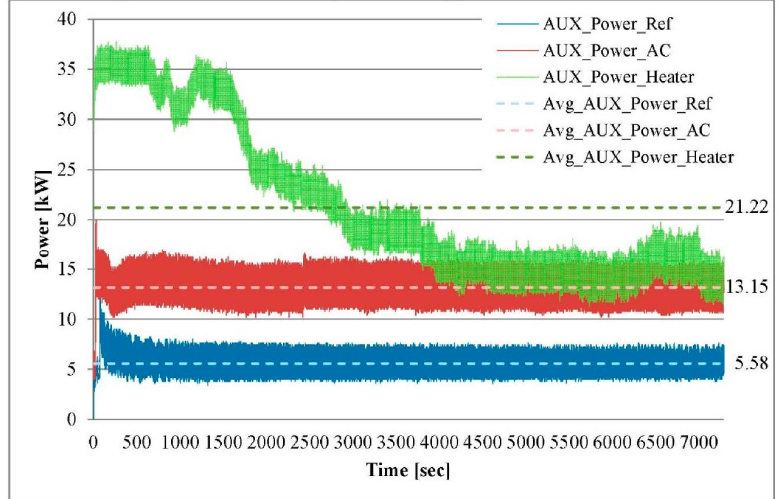
Figure 8. Direct comparison of SOC traces for the Pohang bus route from experiment and